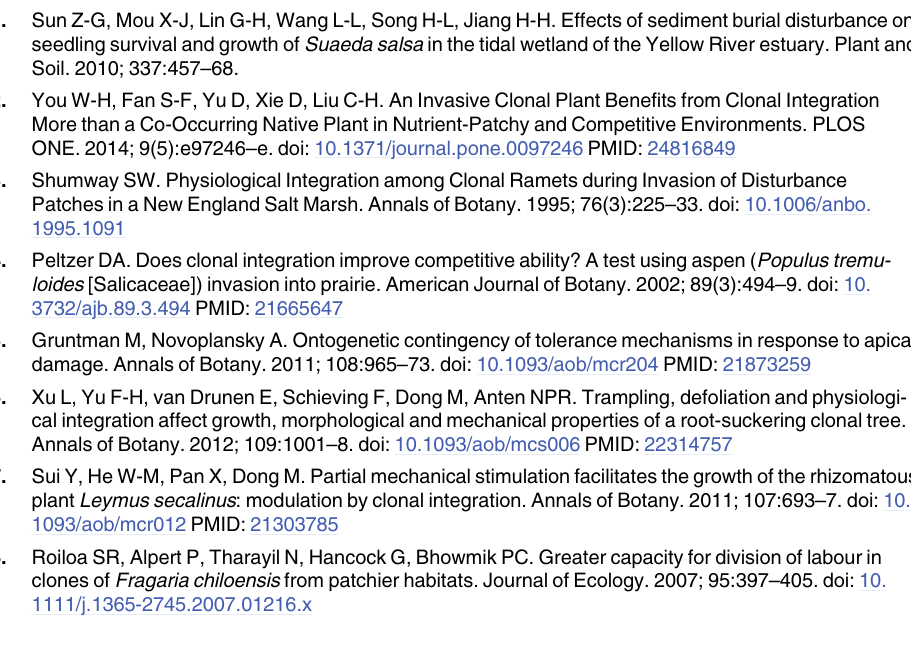
S1 Table. The average values of the morphological,growth and Cu accumulation traits of Alternanthera philoxeroides